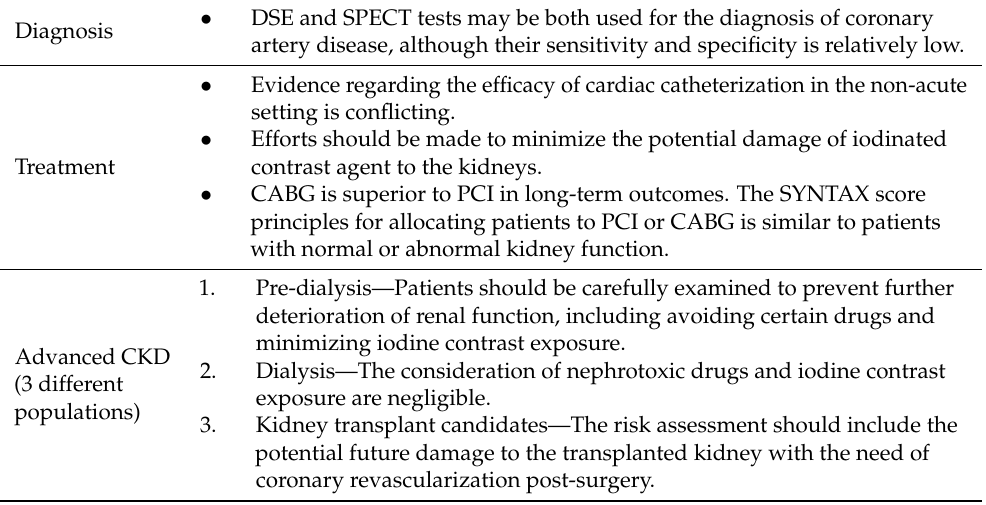
Table 2. Key messages in chronic coronary syndrome and kidney